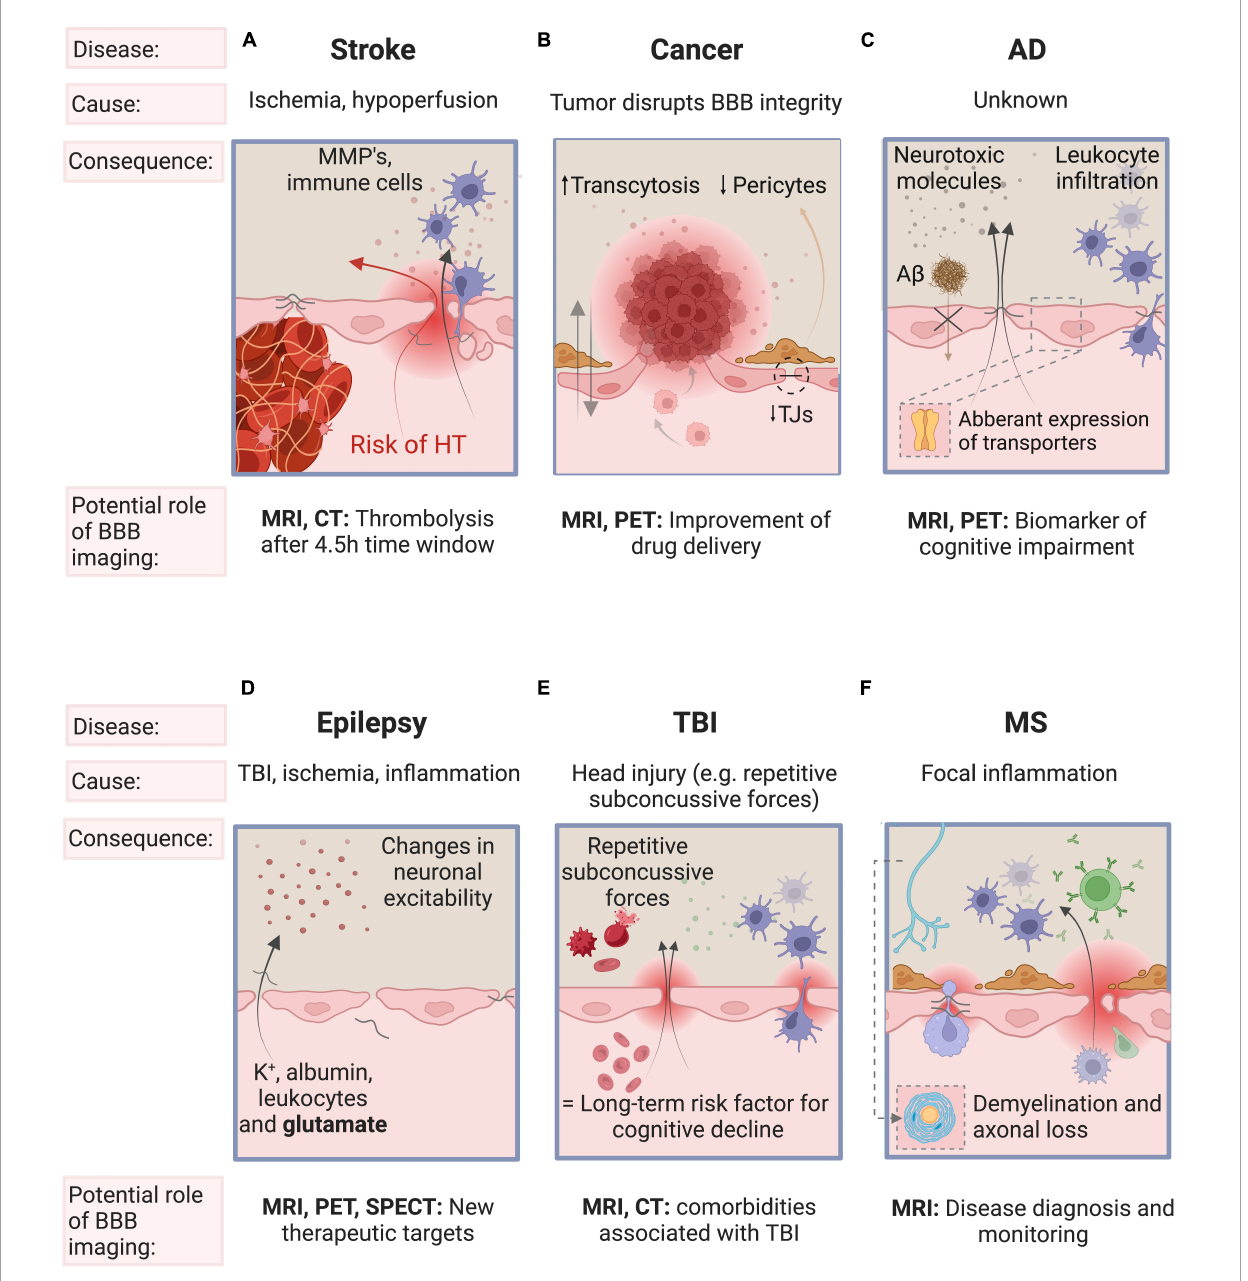
FIGURE2 Schematic representation of the main processes driving BBB disruption, the key factors involved and the role of BBB imaging in stroke, cancer, AD, epilepsy, TBI, and MS. (A) BBB breakdown is initiated by ischemia and deteriorates with sustained hypoperfusion and inflammation. BBB breakdown is a precursor of more serious clinical consequences of ischemic stroke such as hemorrhagic transformation. (B) Brain tumors may disrupt the integrity of the BBB by the secretion of VEGF and is characterized by neurovascular decoupling, altered pericyte populations, reduction in the expression of tight junctions and changes in transcytosis mechanisms. (C) The initial insult leading to BBB breakdown is unknown. The resulting influx of pro-inflammatory molecules and the disturbed clearance of tau and A β triggers vascular-mediated secondary neuronal injury, degeneration and cognitive impairment in AD. (D) Epilepsy may induce BBB dysfunction, and conversely, BBB disruption may also cause (further) epileptic episodes. (E) Repetitive subconcussive forces and subsequent BBB dysfunction is known to be a risk factor for epilepsy and for late-life dementia (especially AD). (F) In MS, focal inflammation secondary to BBB disruption may trigger an inflammatory cascade leading to demyelination and axonal loss. Some features of the BBB have been omitted for simplicity (see Figure 1 for a detailed overview of the components of the BBB). AD, Alzheimer’s Disease; TBI, traumatic brain injury; MS, multiple sclerosis; BBB, blood-brain barrier; VEGF, vascular endothelial growth factor; TJ, tight junctions; A β , β -amyloid; K + ,